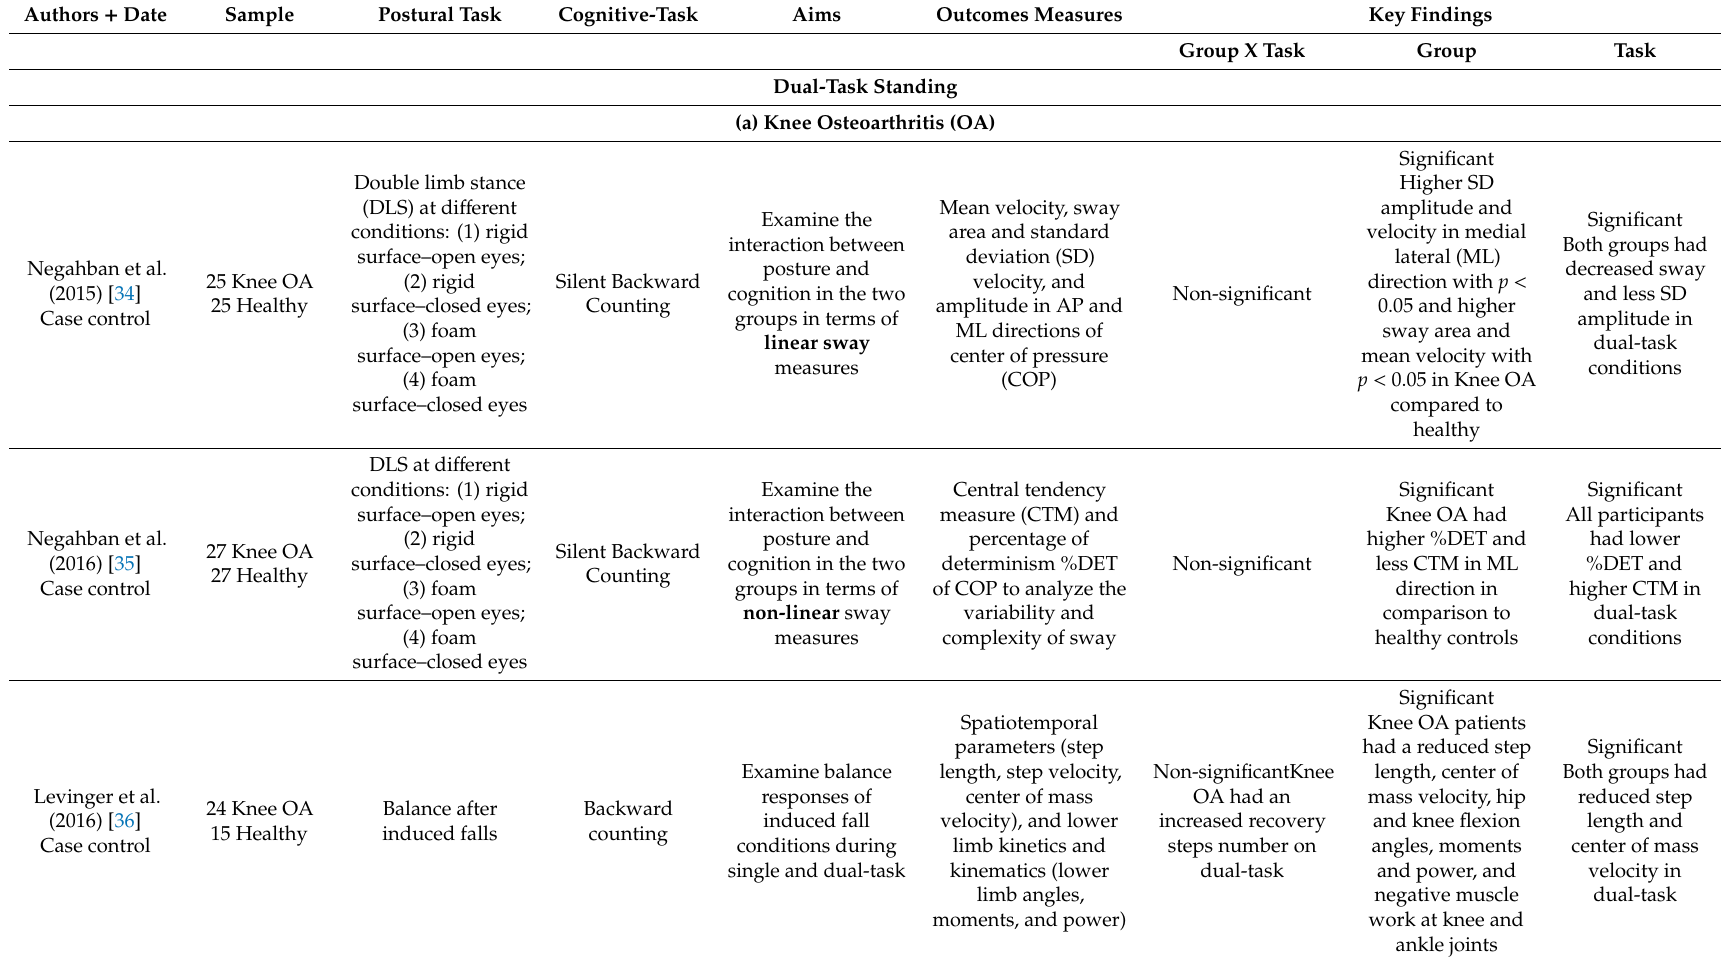
Table 1. Studies included in this review dealing with dual-task during